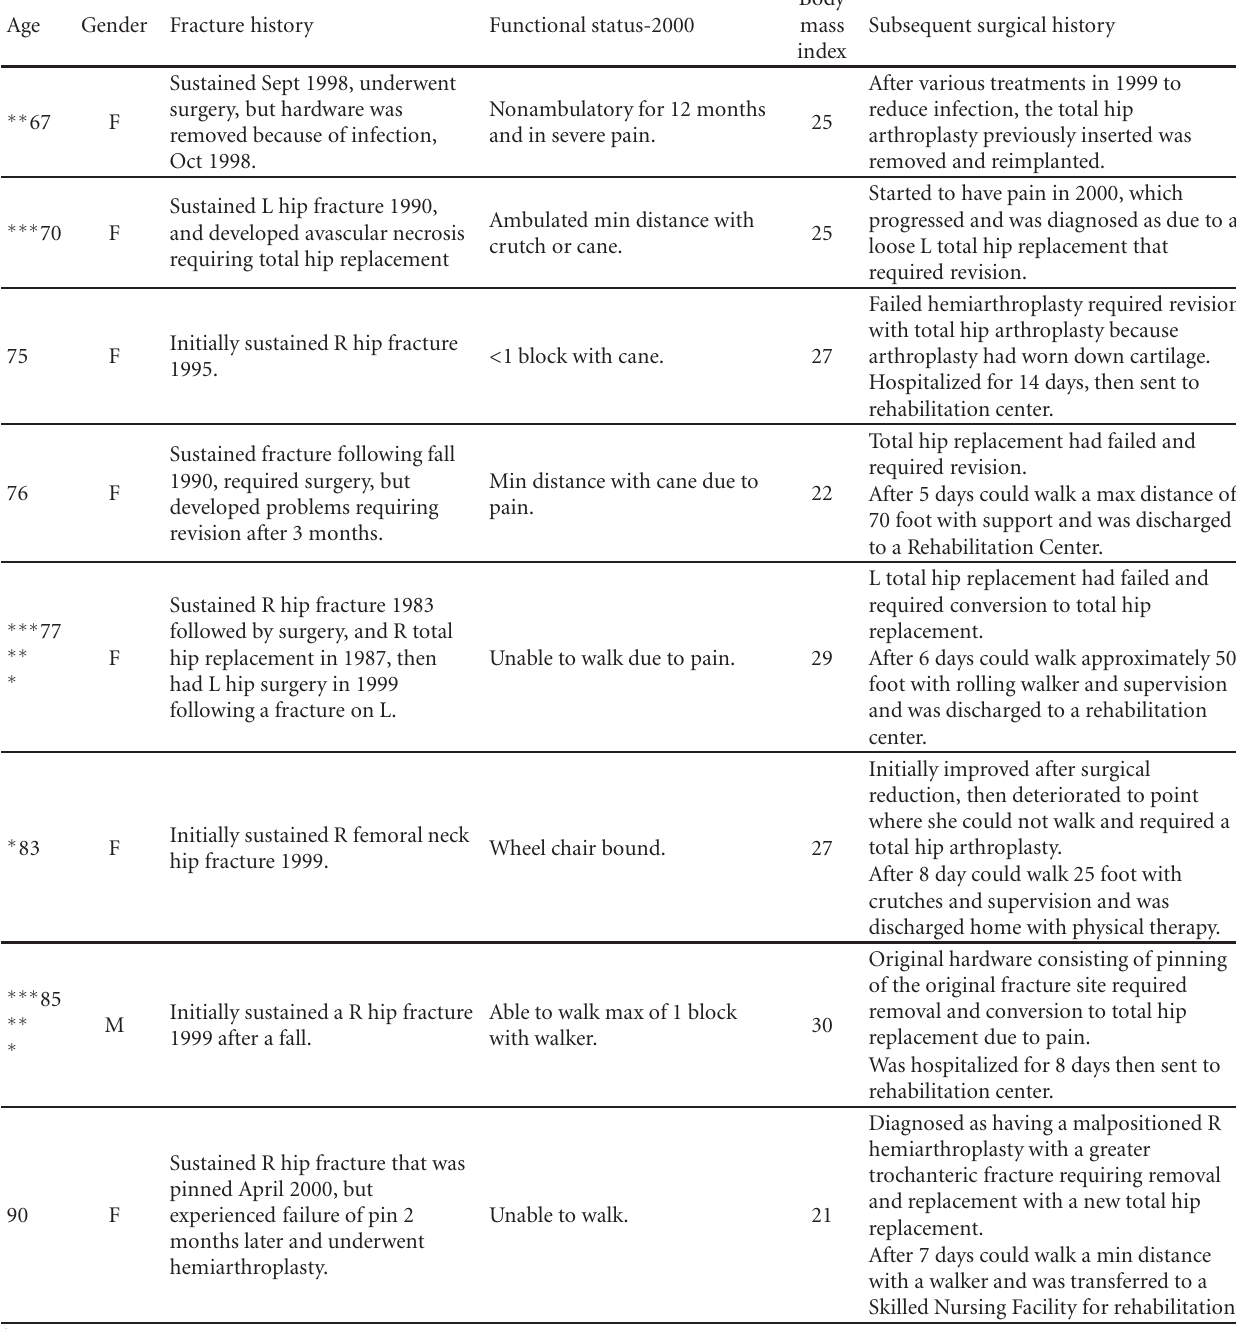
Table 1: Selected cases with a hip fracture history, their body mass indices, and their disability levels, showing only 25% of cases are underweight [48]. Age Gender Fracture history Functional status-2000